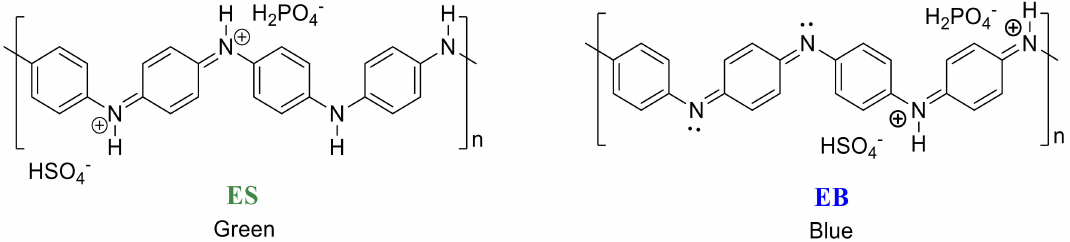
Figure 2. Structure of ES (emeraldine salt) and EB (emeraldine base).